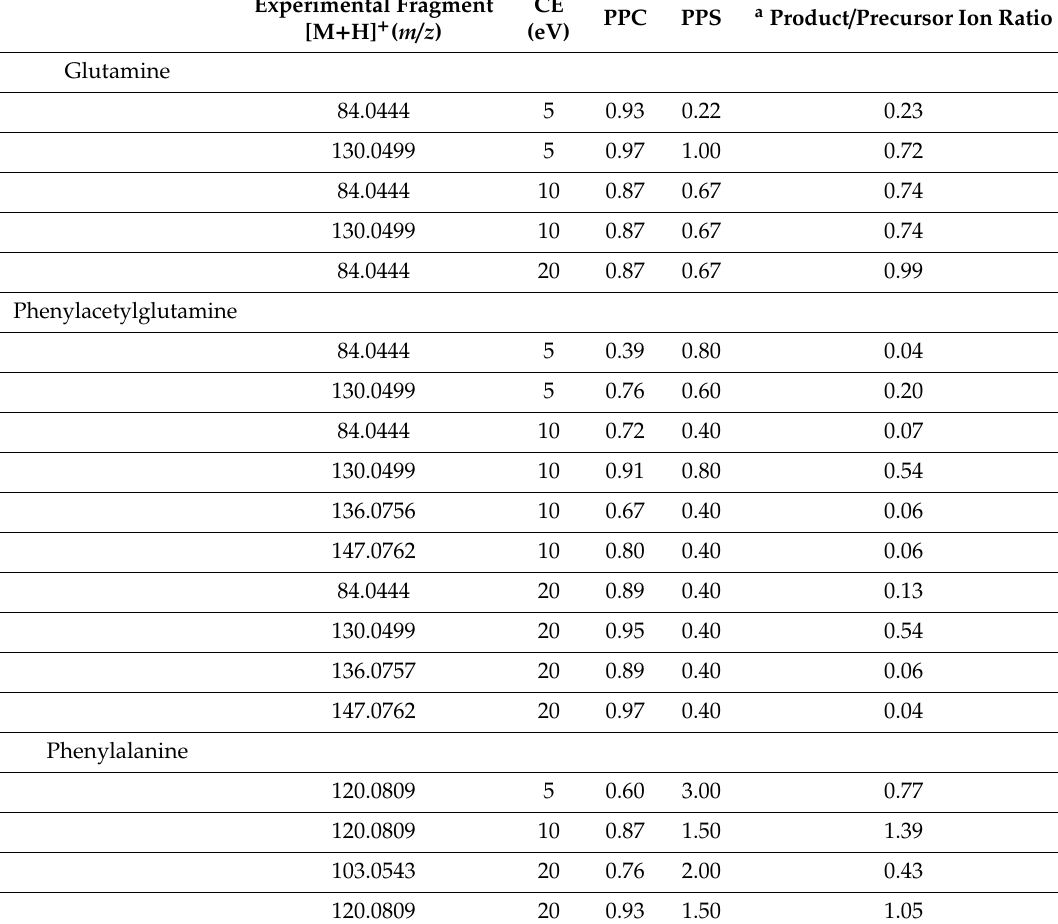
Table 1. Statistical evaluation of peak groups for glutamine, phenylacetylglutamine, and phenylalanine performed by ScoresDIA.R function. Analysis performed on an LC-qTOF instrument. The recommended cut-o ff for PPC is ≥ 0.7. Good chromatographic similarity is indicated by PPS scores between 0.3 and 3. Abbreviations used: CE, Collision Energy; PPC, peak-to-peak Pearson correlation; PPS, peak-to-peak shape